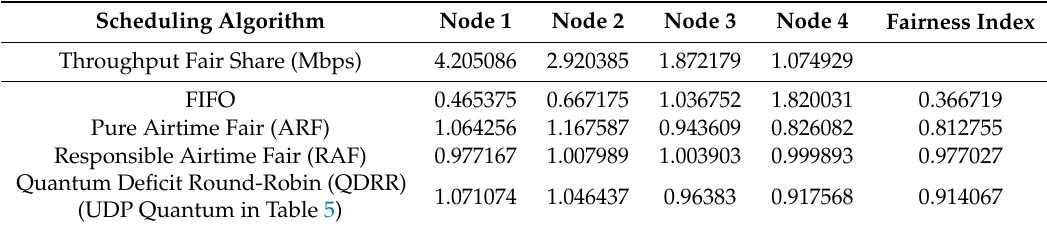
Table 8. Throughput Achieving Ratio and Fairness Index in Variable Length UDP Traffic.